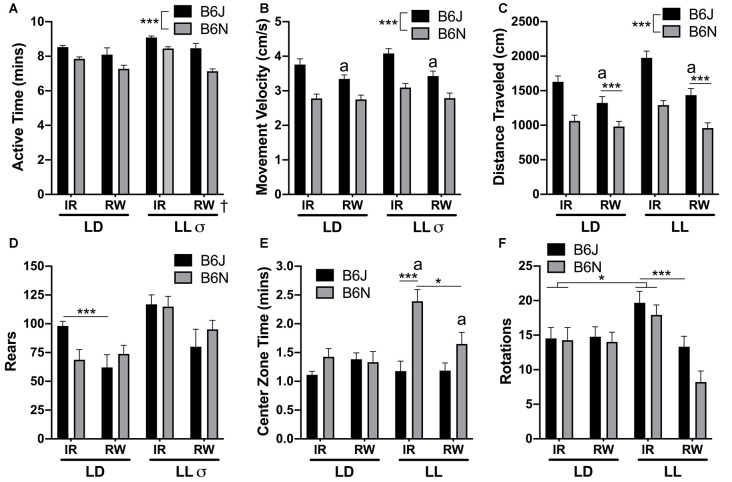
Open-field. (A) Photoperiod (LD < LL), cage (RW < IR), and strain (N < J) differences were observed for active time. (B) B6Js have greater velocity compared to B6Ns and reduce their velocity with RW compared to IR regardless of lighting condition [a = B6J/RW < B6J IR (in LD or LL)]. (C) B6J mice exhibited increased distance traveled compared to B6N, but RW reduces distance for B6Js only (although still significantly greater than B6N/RW groups), regardless of lighting condition [a = B6J/RW < B6J IR (in LD or LL)]. (D) LL increases rearing behavior in both strains but RW reduces it for B6Js only in LD. (E) B6N in LL exhibited the greatest center zone time amongst all other groups [a = B6N/LD < B6N/LD (in RW or IR)]. B6N mice with RW had lower center zone time than B6N in IR cages in LL. (F) In IR cages, LL increased total rotations compared to LD but RW reduced rearing due to LL, regardless of strain. †Running-wheel difference, σLD vs. LL difference, *significantly different from each other at p < 0.05, ***p < 0.001. aDenotes significant difference of the comparison previously described, at p < 0.05.